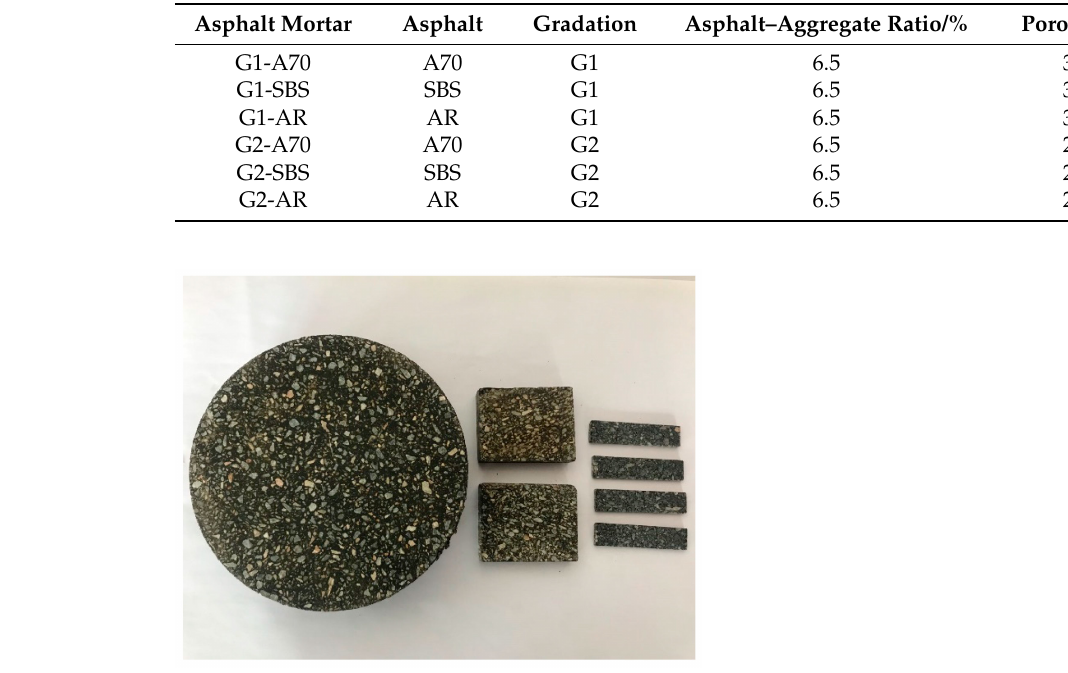
Figure 1. Asphalt mortar